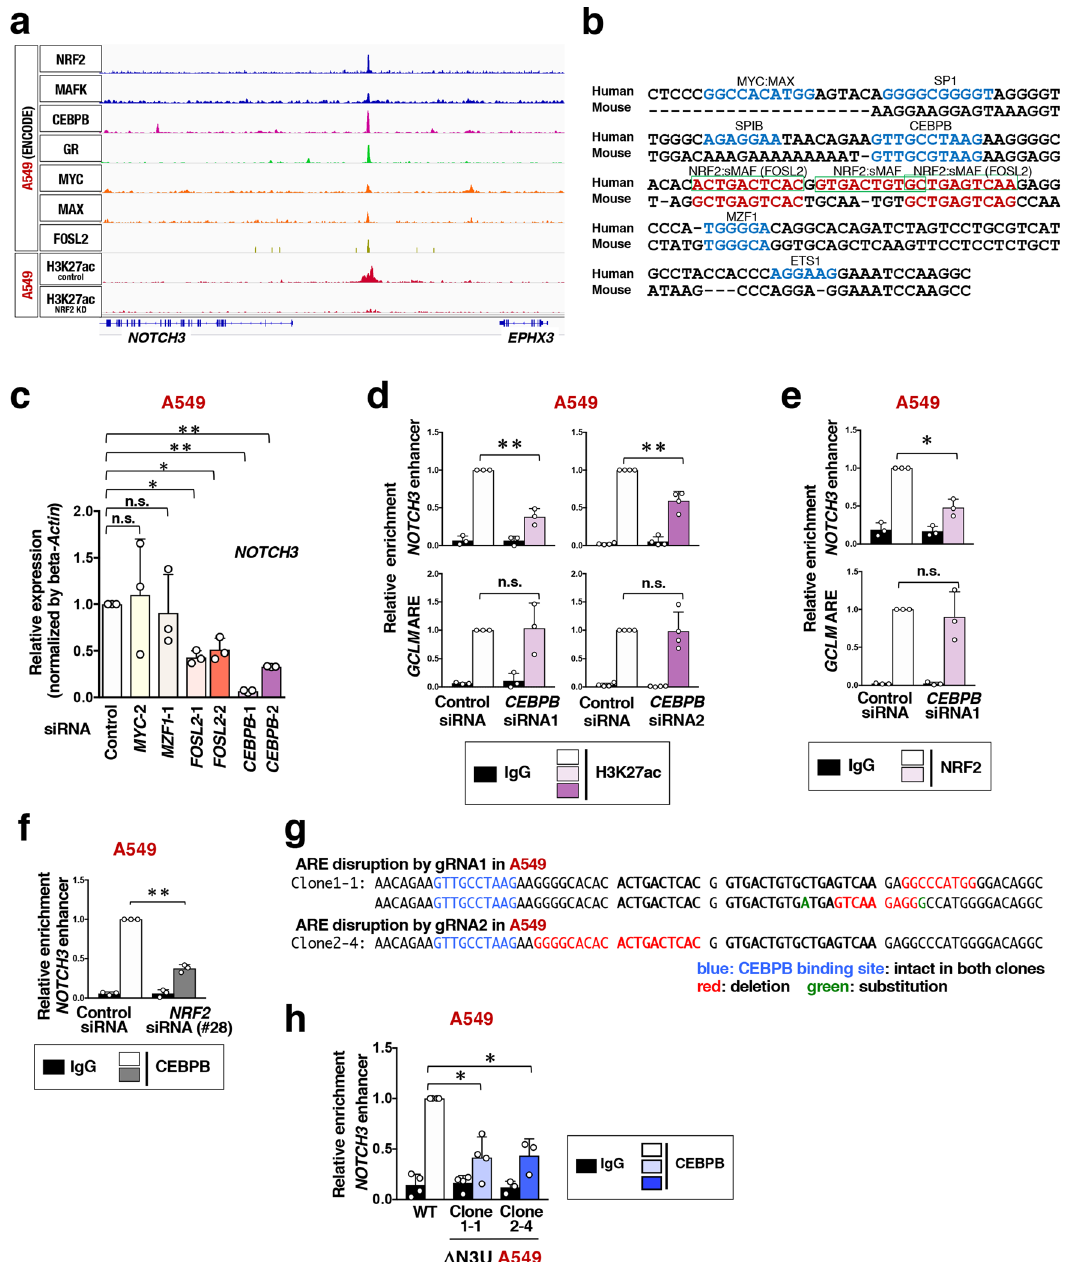
Fig. 8 CEBPB-NRF2 cooperation is required for NOTCH3 enhancer formation in NRF2-activated NSCLC cells. a ChIP-seq pro fi les of the NOTCH3 locus in A549 cells. b Sequence comparison of fl anking regions surrounding NRF2 binding sites in the NOTCH3 enhancer between human and mouse. AREs (NRF2: sMAF binding sites) are shown in red, and three tandem human AREs are enclosed by green frames. Consensus binding motifs of other transcription factors are shown in blue. c RT-PCR of NOTCH3 in A549 cells treated with siRNAs. Fold changes of the normalized values were calculated in comparison to A549 cells treated with control siRNA. The average and SD of the fold changes from three independent experiments are shown. Comparison was made between two cell groups; control siRNA and each test siRNA. Two-sided con fi dence interval estimation was conducted to evaluate statistical signi fi cance. * α < 0.05, ** α < 0.01, n.s.: not signi fi cant. d , e ChIP assay using the H3K27ac ( d ) and NRF2 ( e ) antibodies in A549 cells treated with control siRNA or CEBPB siRNA. Fold changes of %input values were calculated in comparison to the control samples incubated with H3K27ac or NRF2 antibody. The average and SD of three independent experiments are shown except for the experiment with CEBPB siRNA2 in d , which was independently conducted for four times. Two-sided con fi dence interval estimation was conducted for knockdown samples incubated with H3K27ac or NRF2 antibody. * α < 0.05, ** α < 0.01, n.s.: not signi fi cant. f ChIP assay using the CEBPB antibody in A549 cells. Fold changes of %input values were calculated in comparison to the control samples reacted with CEBPB antibody. The average and SD of 3 independent experiments are shown. Two-sided con fi dence interval estimation was conducted for knockdown samples reacted with CEBPB antibody. ** α < 0.01. g DNA sequence of Δ N3U A549 cells. A CEBPB binding site, shown in blue, is preserved in both Δ N3U A549 clones. Deletion and substitution by genome editing are shown in red and green, respectively. h ChIP assay using the CEBPB antibody in Δ N3U and wild-type (WT) A549 cells. Fold changes of %input values were calculated in comparison to WT A549 cells incubated with CEBPB antibody. The average and SD of 3 (Clone 2 – 4) and 4 (WT and Clone 1 – 1) independent experiments are shown. Comparison was made between two cell groups; WT A549 and each mutant clone. Two-sided con fi dence interval estimation was conducted for Clones 1 – 1 and 2 – 4 incubated with CEBPB antibody. * α <